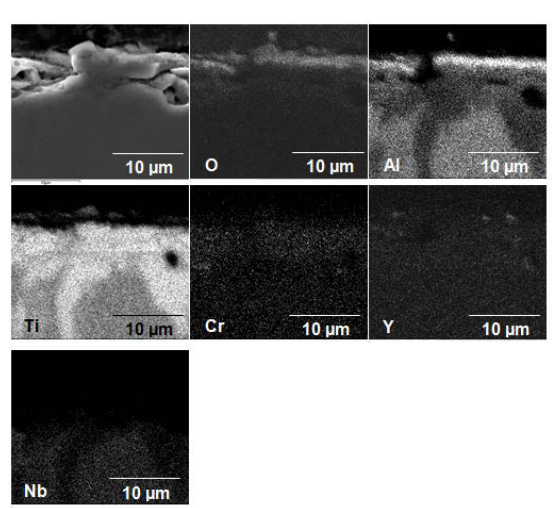
Figure 7. Digimaps of TiAlCrY coated Ti45Al8Nb after 500 hours oxidation at 950 ◦